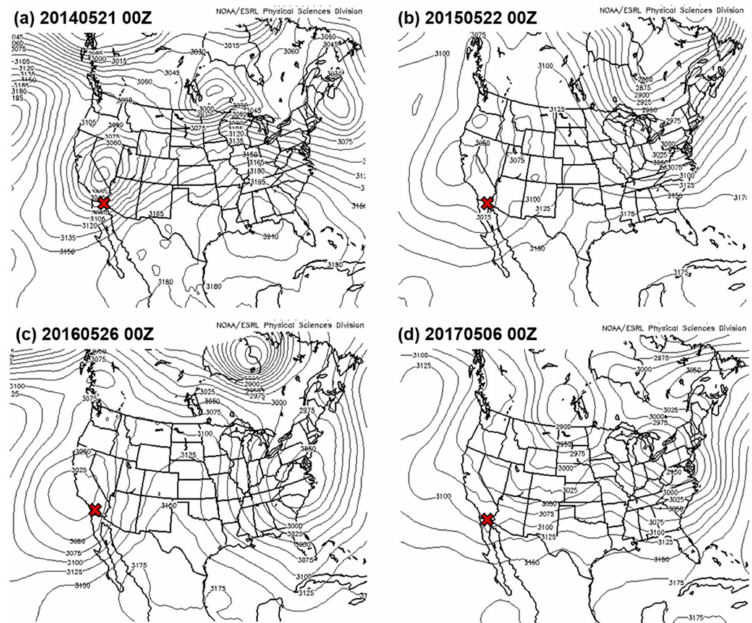
Figure 3. The 700 mb geopotential height fields (meters) from the North American Regional Reanalysis [28] for four west-southwesterly (WSW) high wind events a ff ecting the Imperial Valley. The red X on each panel is the approximate location of valley. Plots were created from the NARR plotting website operated by NOAA / OAR / ESRL PSD, Boulder, Colorado, USA (https: // www.esrl.noaa.gov / psd / data / gridded / data.narr.html).